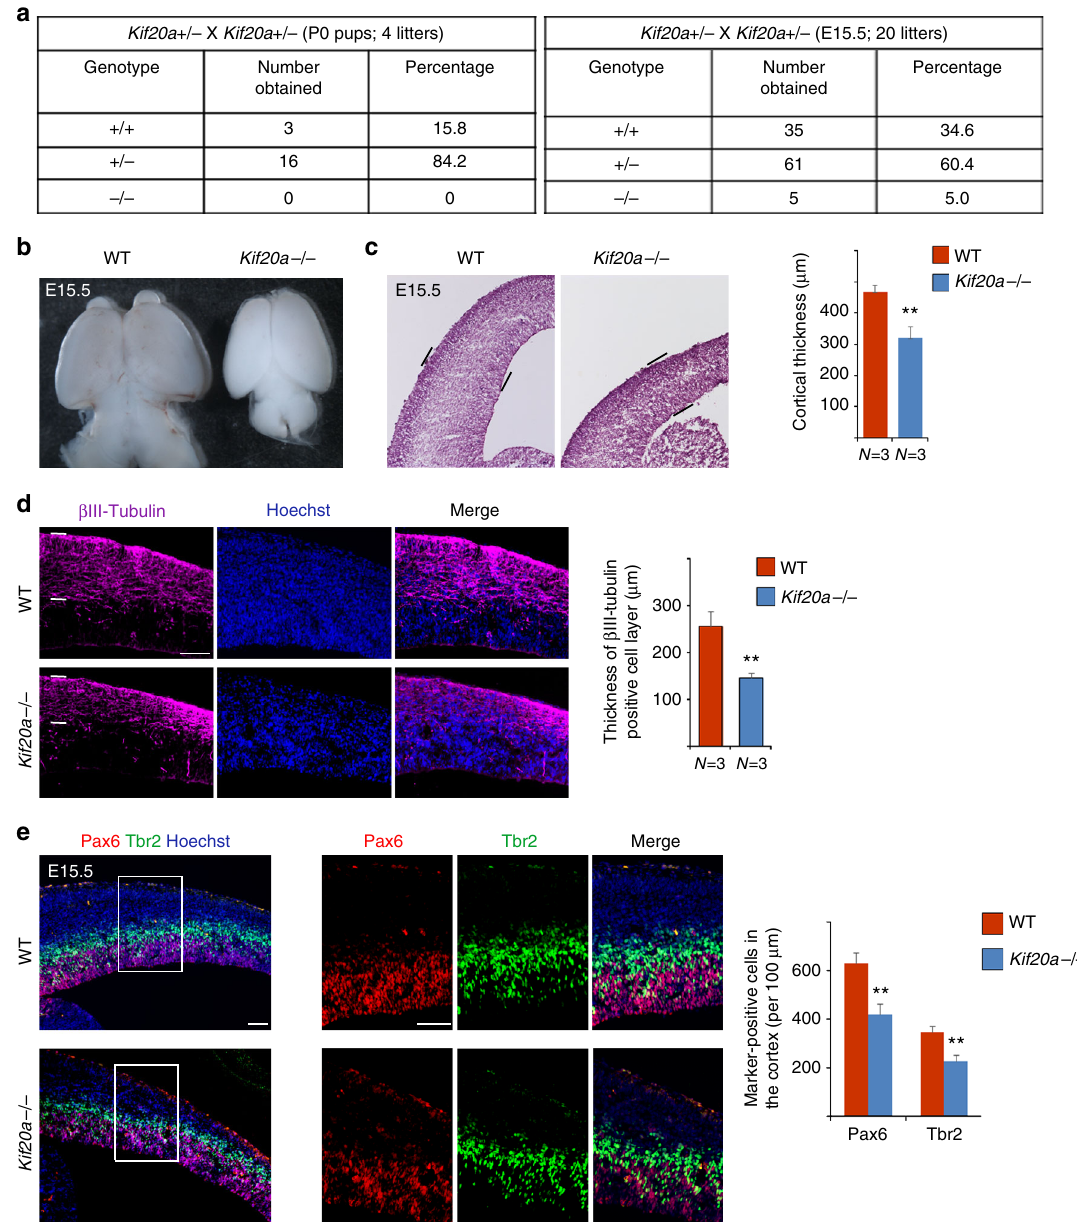
Fig. 5 Germline knockout of Kif20a causes embryonic lethality and loss of cortical NPCs. a Low recovery rate of homozygous Kif20a knockout fi rst pups or embryos showed embryonic lethality due to loss of function of KIF20A. b At the peak of cortical neurogenesis (E15.5), brains from the surviving Kif20a homozygous mutant embryos were smaller than their wild-type littermates. c Nissl staining of brain sections revealed thinner cortices of the Kif20a homozygous mutant brains at E15.5. ** P < 0.01. d Kif20a homozygous mutant brains had fewer β III-tubulin + neurons at E15.5. ** P < 0.01. Scale bar represents 100 μ m. e Kif20a homozygous mutant brains had fewer Pax6 + radial glial cells and fewer Tbr2 + intermediate progenitor or basal progenitor cells at E15.5. ** P < 0.01. Scale bar represents 100 μ the mutant NPCs. Further examination of cell marker expres- apparent thickening of the R2 ribbon but a signi fi cant loss of sion showed that BrdU + Ki67 − cells that had migrated into the the R3 ribbon, as compared to the wild-type littermate brains CP were positive for neuronal marker NeuN (Fig. 7b), sug- (Fig. 7a). The thickening of R2 ribbon in the mutant cortices gesting that mutant NPCs, which left the cell cycle earlier, had suggested that during this cell cycle, more labeled cells might differentiated into neurons. have differentiated than those in the wild-type cortices. The loss of R3 ribbon was likely a cumulative result caused by early depletion of the NPC pool during previous cycles of cell divi- sions. Quanti fi cation revealed that there was a higher portion of + − + Ki67 cells (cells exited the cell cycle) in the BrdU BrdU population of the mutant cortices than that of the wild-type littermate cortices (Fig. 7a), suggesting an early cell cycle exit of